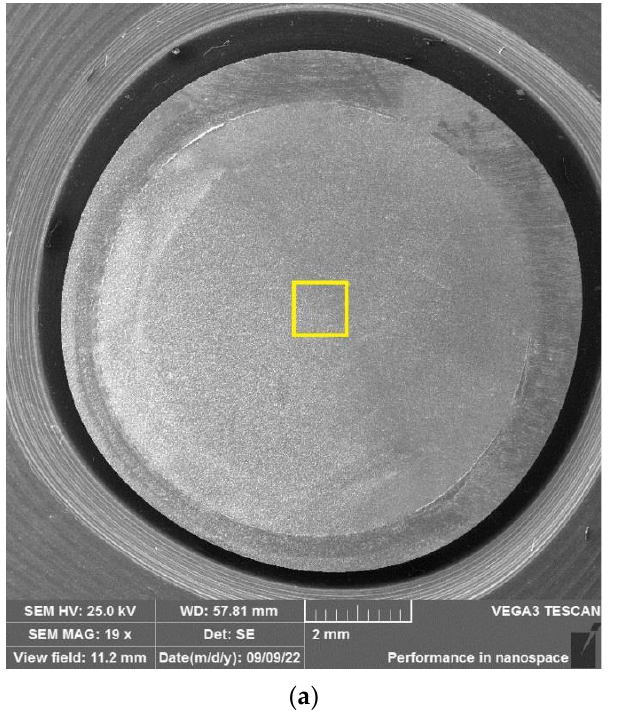
Table 4. The values P 20, P aut , σ max , σ y , σ max /σ y and t values for 12Cr F/M steel.